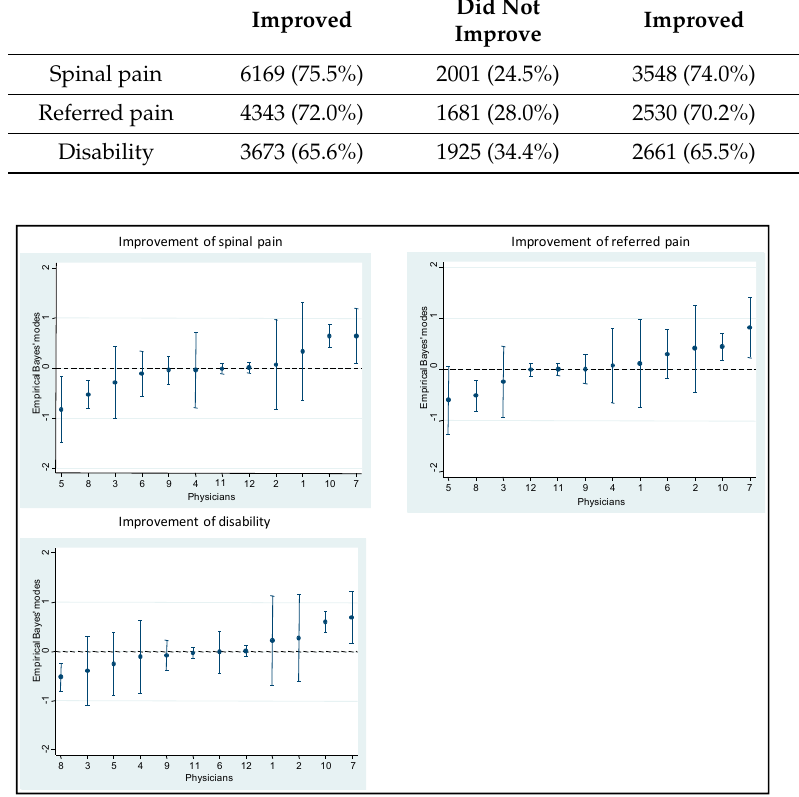
Figure 3. Empirical Bayes’ residuals of the variability of each physician for each outcome.